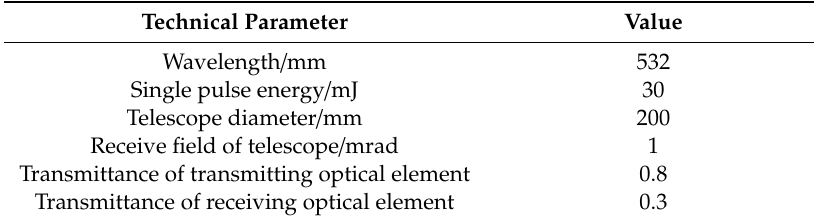
Table 1. The parameters of the ground-based LIDAR.